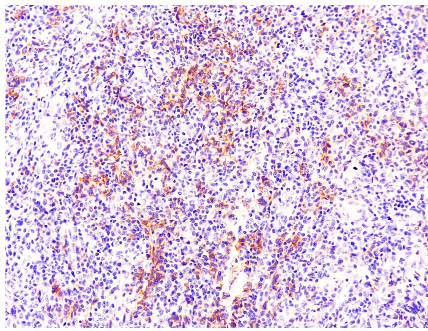
Figure 8. PD-1 staining. Magnification 200×.